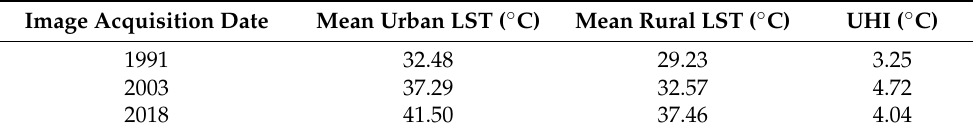
Table 7. Calculation of urban heat island intensity from land surface temperature (LST) based on Landsat